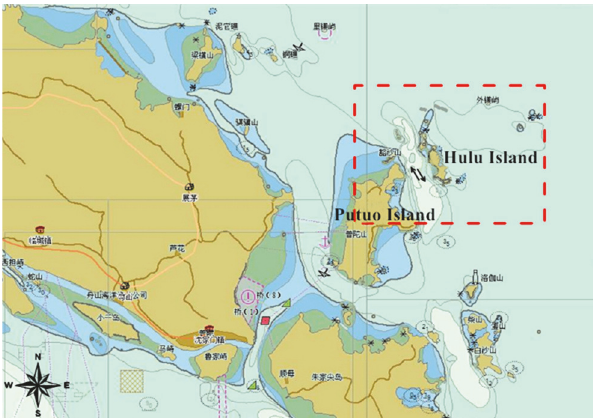
Figure 1: Geographical location of tidal